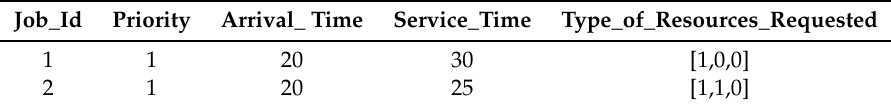
Table 2. An execution